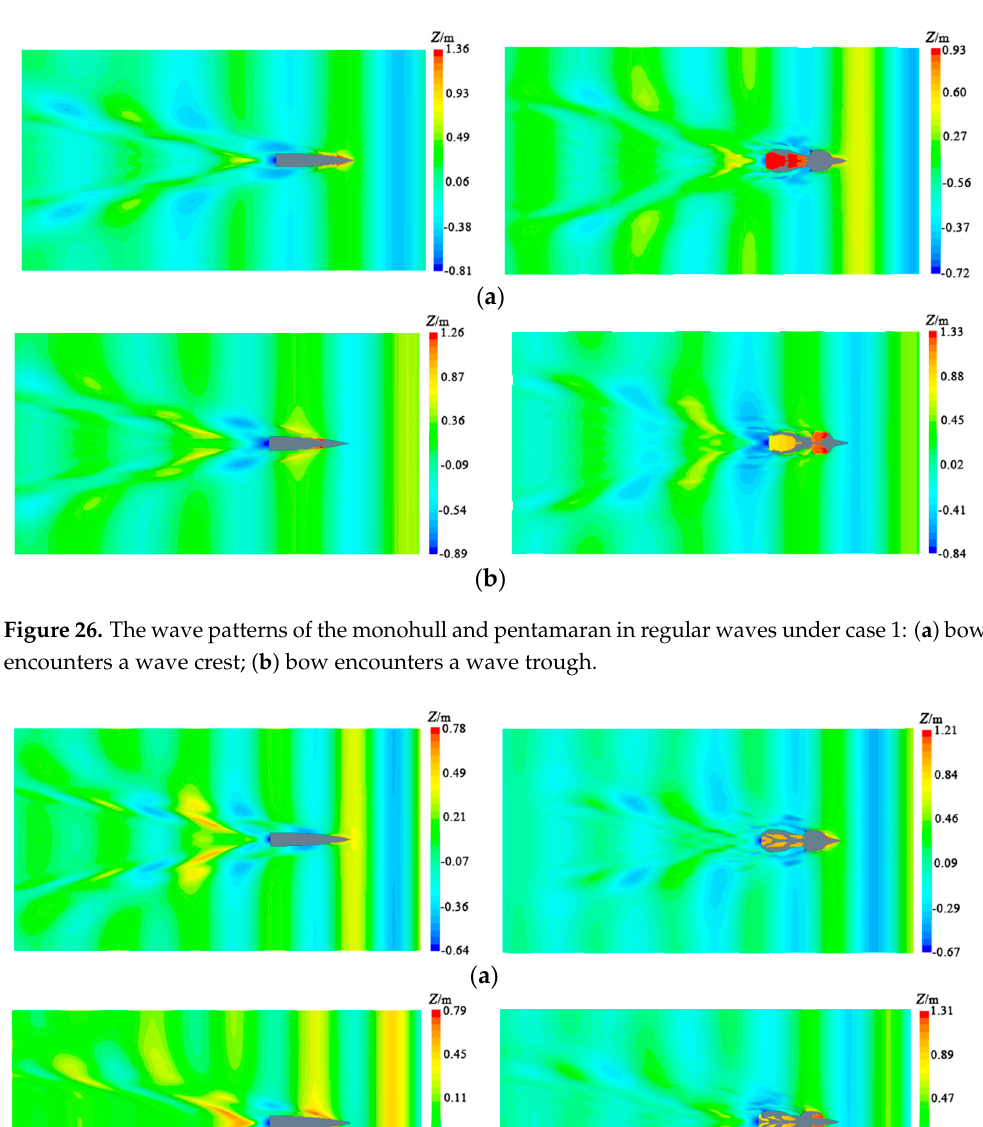
21 of 24 Figure 24. The time history curve of pitch angle under case 6: ( a ) monohull; ( b ) pentamaran. ( a ) ( b ) Figure 25. The time history curve of pitch angle under case 7: ( a ) monohull; ( b ) pentamaran. In conclusion, the calculation results show that the motion response of the monohull